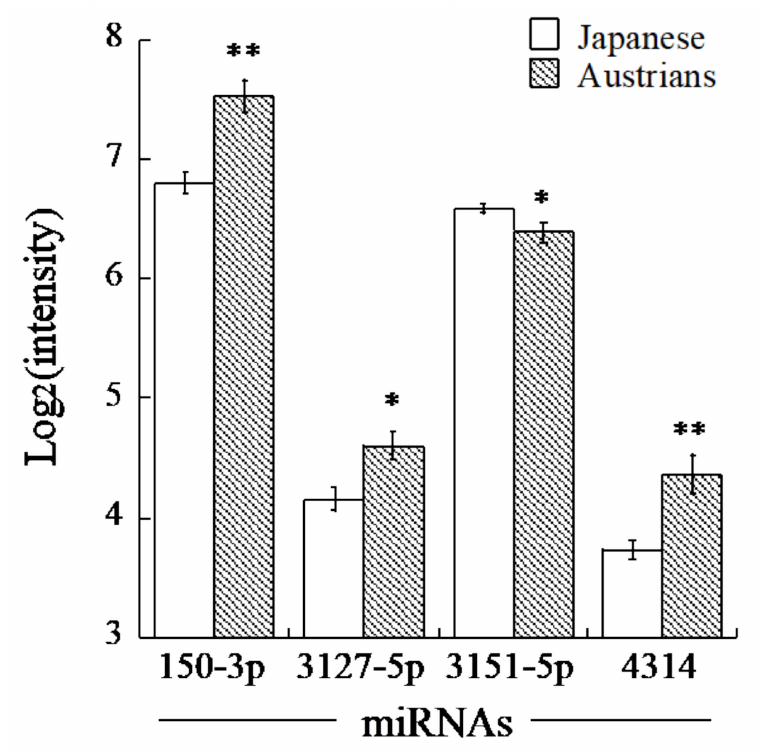
Figure 1. Comparison of miRNA levels in serum of Austrian and Japanese men. Shown are means of log2-transformed levels of each miRNA with their standard errors. Asterisks denote significant differences from the levels of Japanese (*, q < 0.01; **, q <